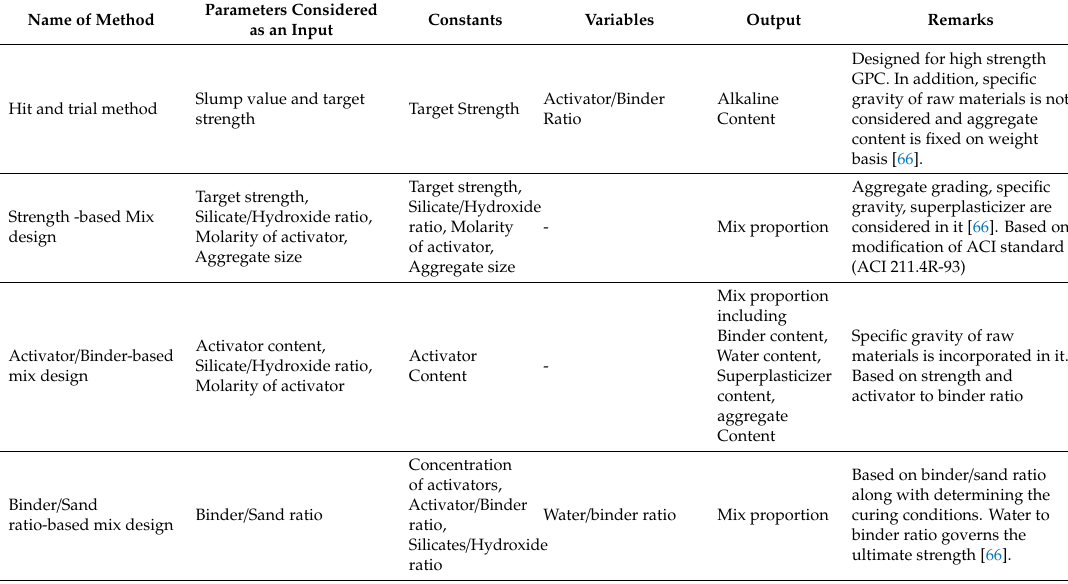
Table 4. Summary of mix designs of